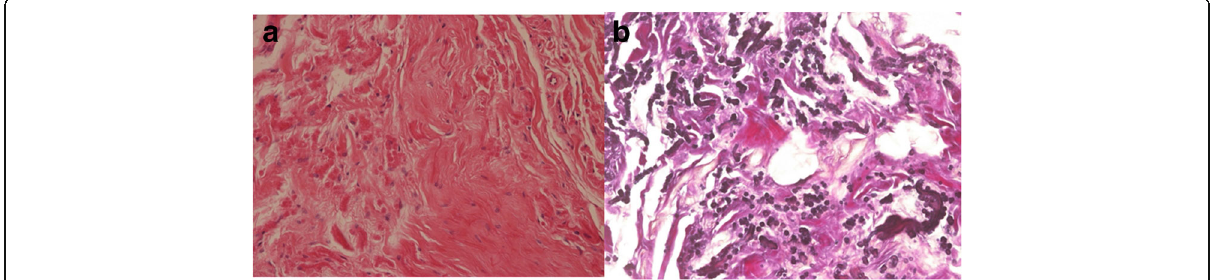
Fig.2 a Hypocellular fibrocollagenous tissue is visible (H&E ×20). b Thick or coarse elastic fibers arranged in beaded strings or globules are demonstrated using elastica van Gieson staining